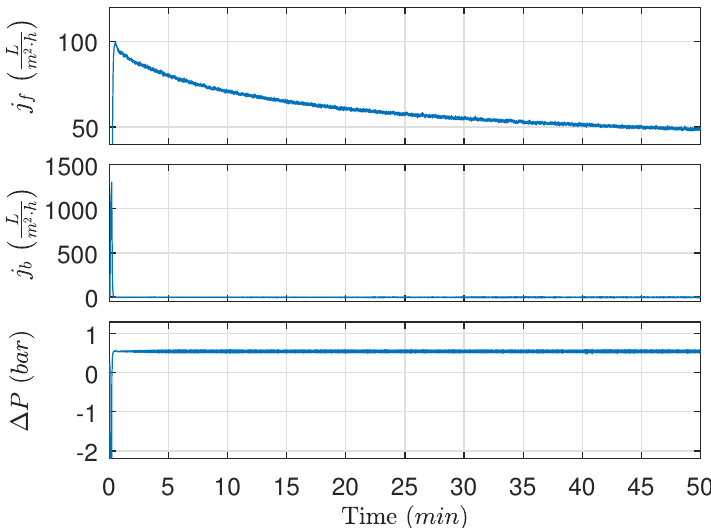
Figure 11. Single filtration cycle, initiated with backwashing and followed by filtration. Experimental conditions: t f = 3000 s, t b = 10 s, Q cf , ref = 1 m , ∆ P f , ref = 0.55 bar, and ∆ P b , ref = − 2 s